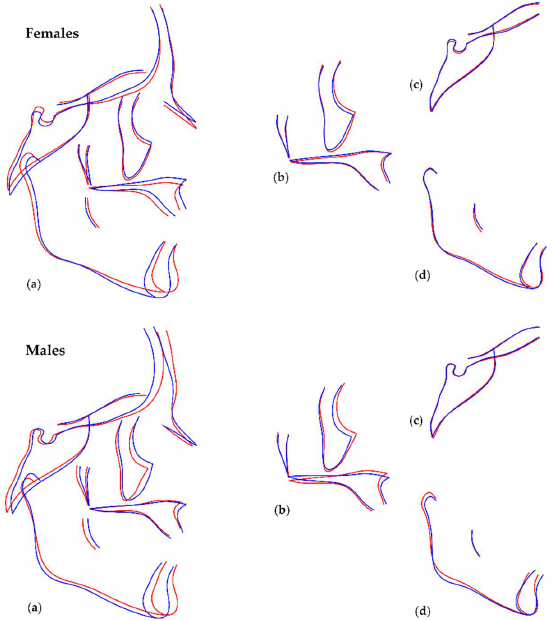
Figure 7. Regression of shape (after removal of allometry effect) on number of missing teeth, without considering third molars, in females (top row) and males (bottom row). The blue lines represent shape configurations in cases with no or minimum missing teeth (−4SD from average shape) and the red lines represent shape configurations in cases with maximum number of missing teeth (+4SD from average shape). The following shape configurations are displayed: ( a ) entire cranial shape, ( b ) maxilla, ( c ) cranial base, ( d ) mandible. Cranial base differences were not statistically significant.